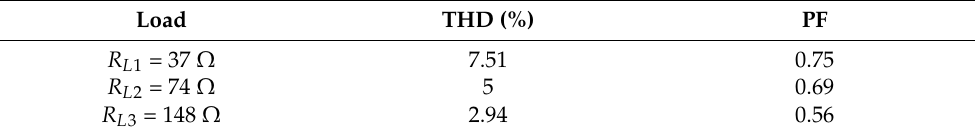
Table 18. ATU total harmonic distortion and power factor under unbalanced input voltage.